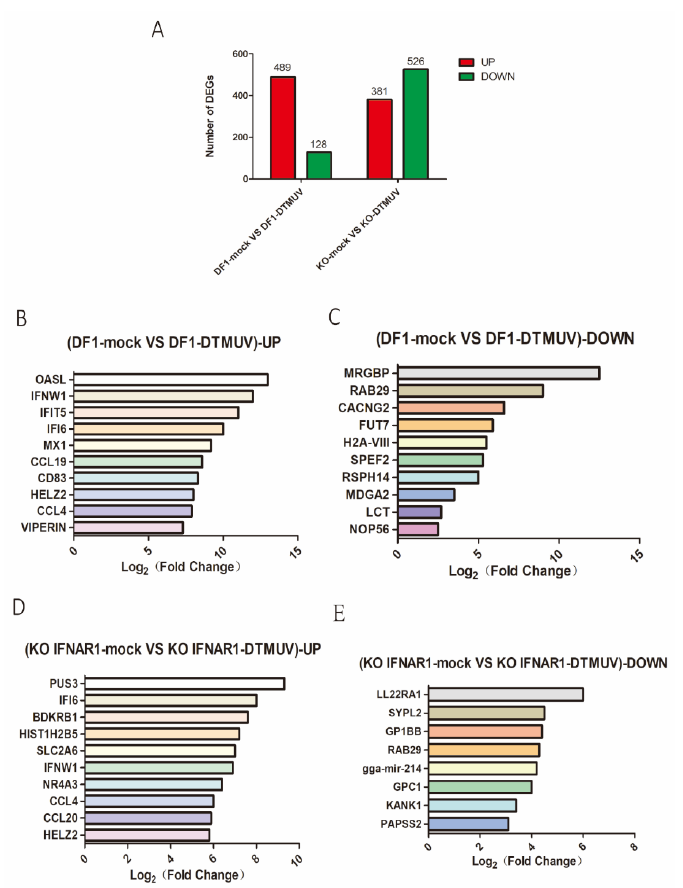
Figure 4. Transcriptomic analysis of differential gene expression in DF-1 and KO-IFNAR1 cells infected with DTMUV. ( A ) The number of up-regulated genes in DTMUV-infected cells at 24 hpi are shown in red, and the down-regulated genes in green. ( B ) Top 10 genes with the highest expression levels among all up-regulated genes in the DF-1 infection group transcriptome data. ( C ) The 10 genes with lowest expression levels among all down-regulated genes in DF-1 infection group transcriptome data. ( D ) Top 10 genes with the highest expression level among all up-regulated genes in the KO-IFNAR1 infection group transcriptome data. ( E ) The 10 genes with lowest expression levels among all down-regulated genes in KO-IFNAR1-infected transcriptome data.